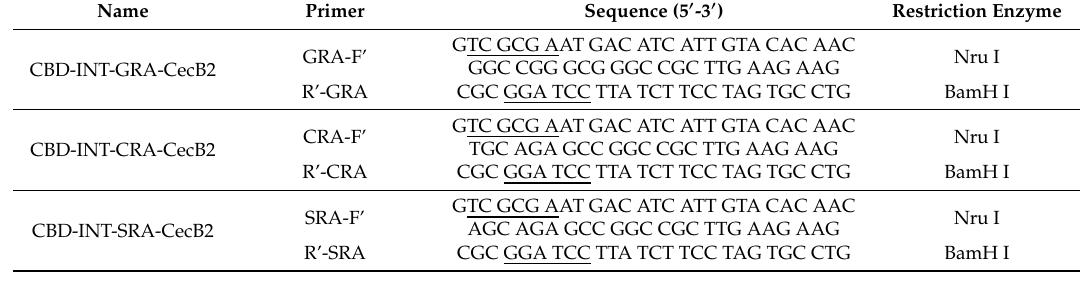
Table 1. Primers used in this study.